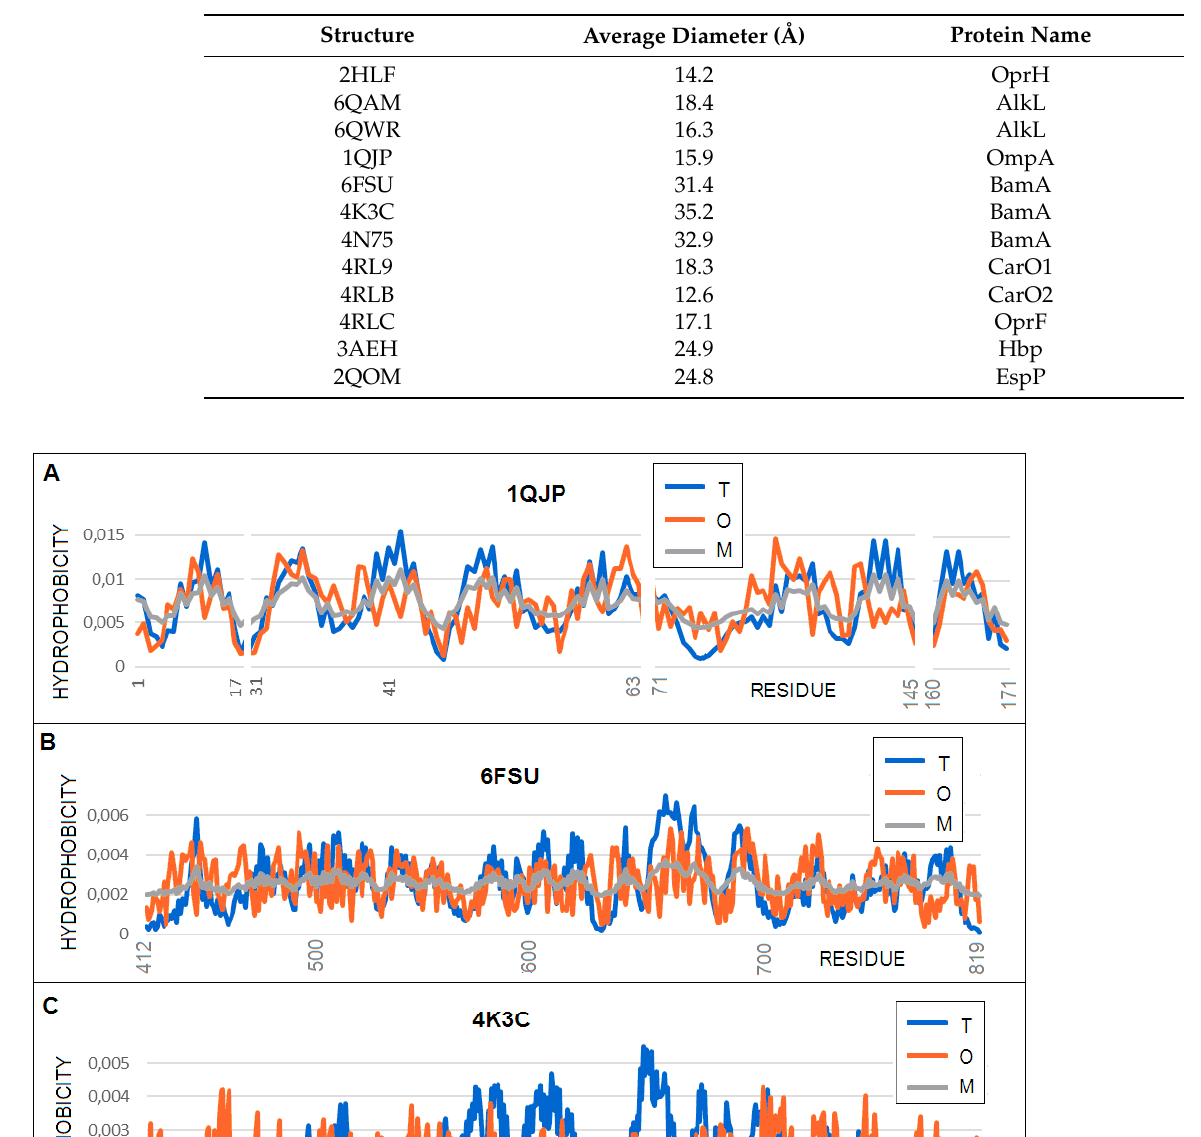
Table 3. The averaged channel diameters in the discussed proteins.